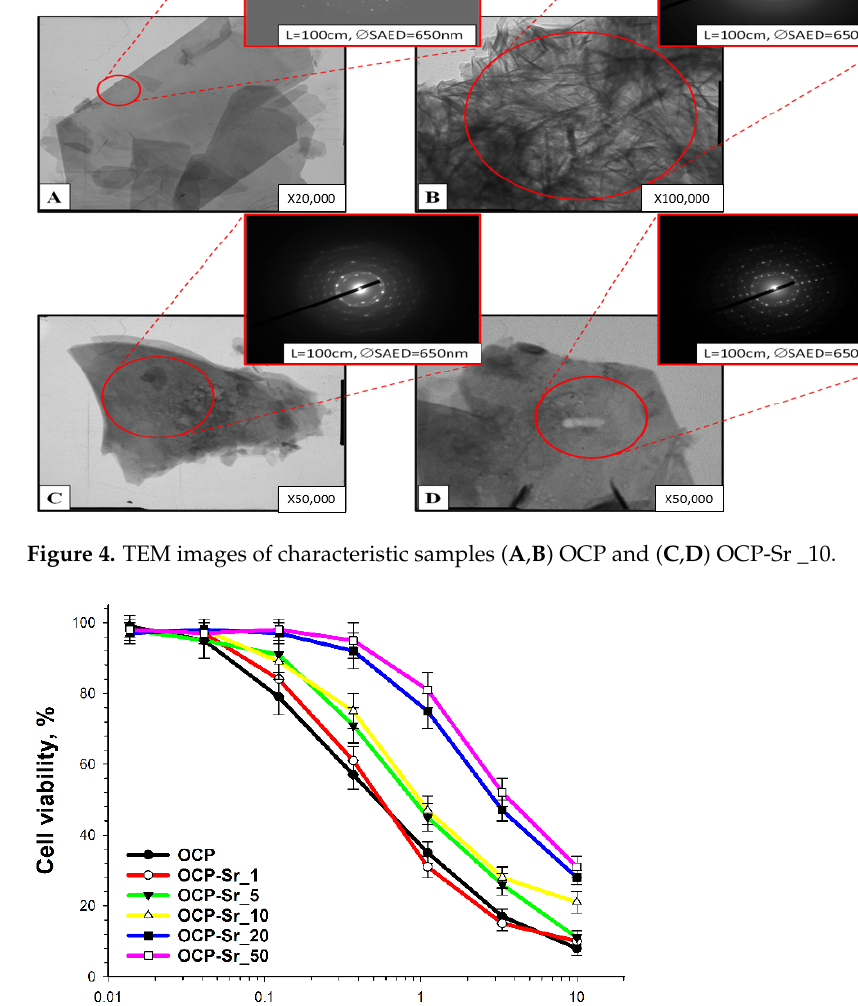
Figure 6. Mitochondrial membrane potential ( a ), quantitative assessment of the fluorescence inten- sity of acid compartments ( b ). Ctrl — untreated cells without the addition of calcium phosphate com- pounds. Val is valinomycin. CHL — chloroquine. MFI — Mean fluoresce intensity. * — statistically sig- nificant difference compared to untreated control cells, p < 0.05. Additionally, to verify flow cytometry data, the content of acidic compartments and mitochondrial membrane potential in C 3 H/10T1/2 cells were examined using confocal mi- croscopy after 96 h of co-incubation with OCP and OCP-Sr. For this, cells were stained